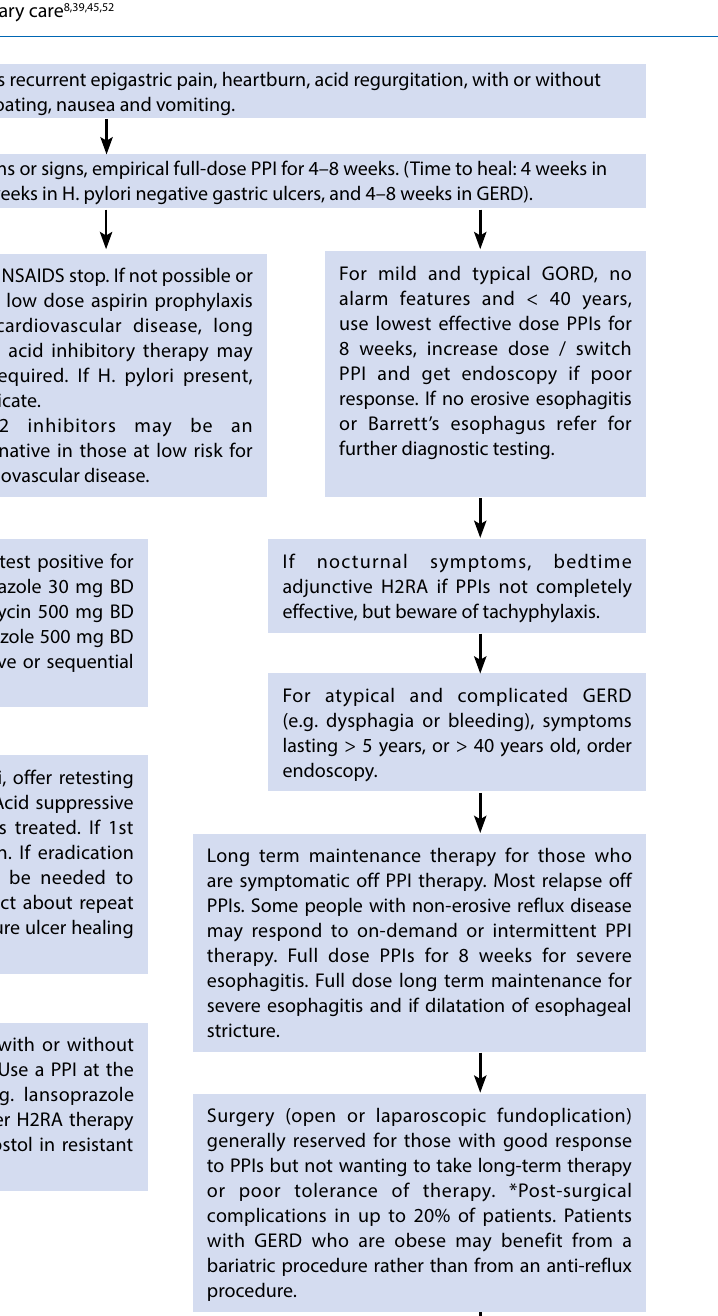
Figure 1: Algorithm for the management of dyspepsia in primary care